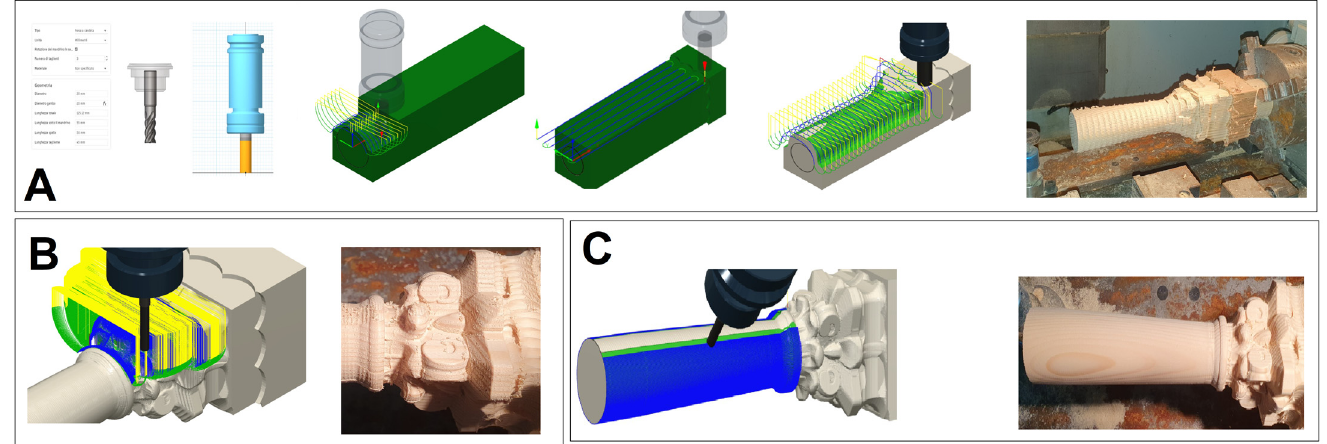
Figure 7. Initial roughing of the workpiece with the “parallel” function and a Ø 20 mm milling cutter ( A ); finishing operations on the capital ( B ); finishing operations on the lower truncated conical part of the column with the “rotary linear multi-axis” function ( C ).